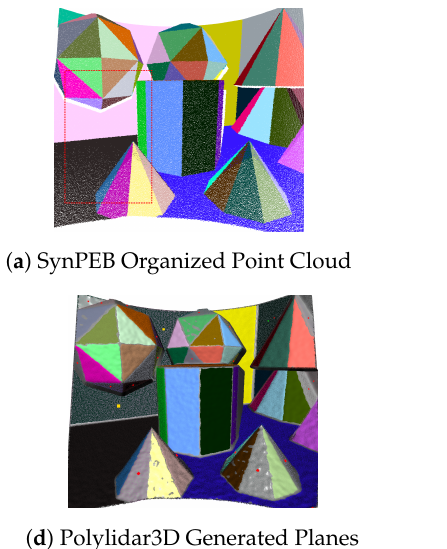
Figure 19. Example SynPEB scene with the highest noise level. Point cloud, generated mesh, and mesh smoothed through Laplacian and bilateral filtering are shown in ( a – c ), respectively. Planes and polygons generated by Polylidar3D are shown in ( d , e ). Red, green, and yellow blocks in ( d ) represent missed, spurious, and oversegmented